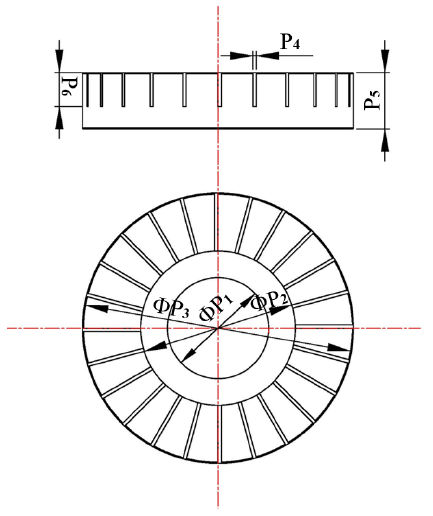
Figure 2. Structural dimension parameters of the stator.